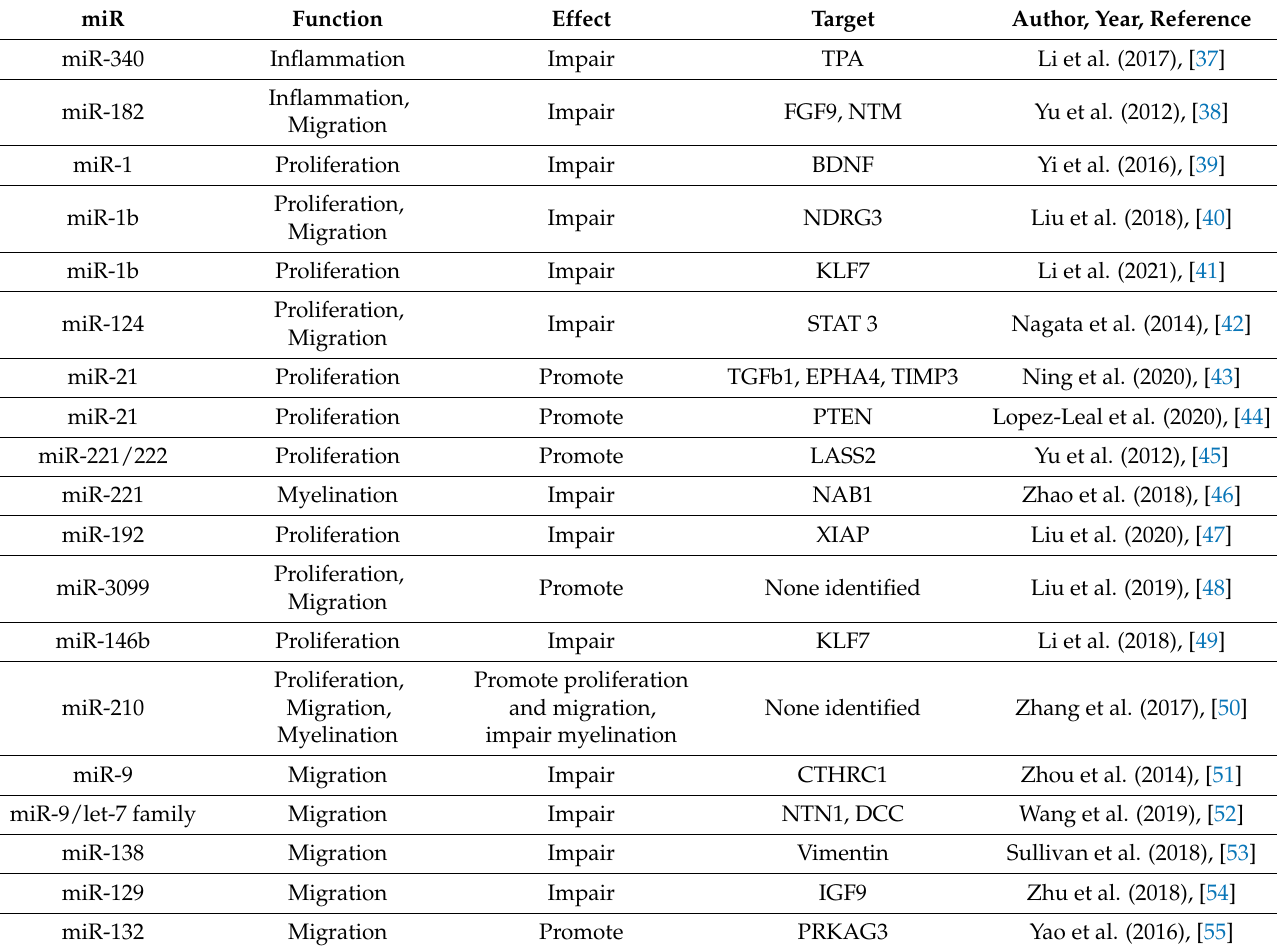
Table 1. List of identified miRNAs sorted by